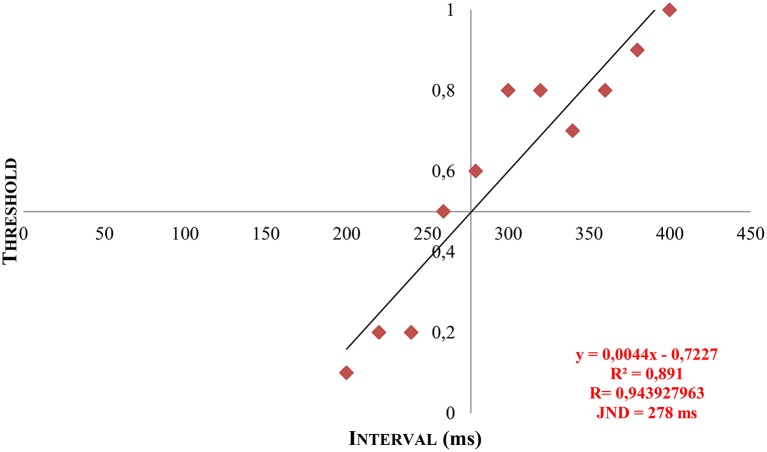
Example of a patient's JND by means of linear regression and extrapolation. Y = calculated gradient of the regression line based on the measured data. R, correlation coefficient. R2, coefficient of determination. x, calculated JND by extrapolation at y = 0.5.